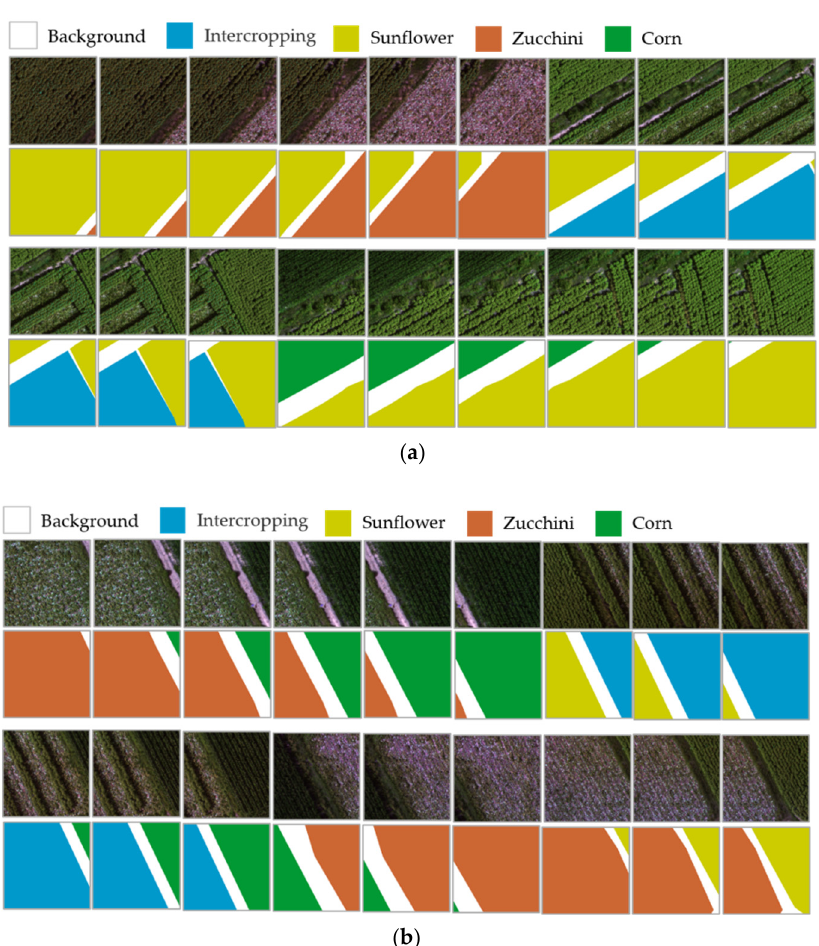
Figure 4. Flowchart of production datasets.